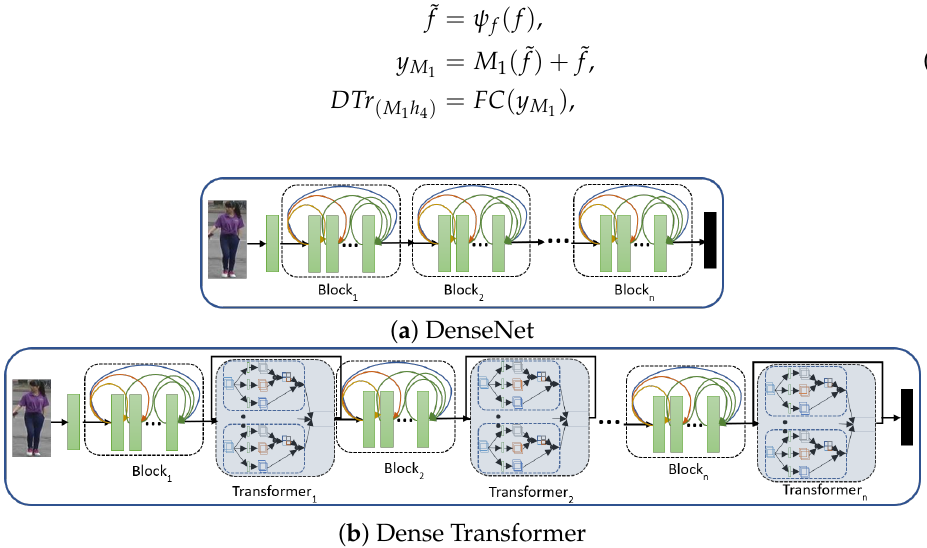
Figure 5. The structure of DenseNet ( a ) and Dense Transformer ( b ). The transformer modules are kept at the network’s end instead of each block in the Dense Transformer.